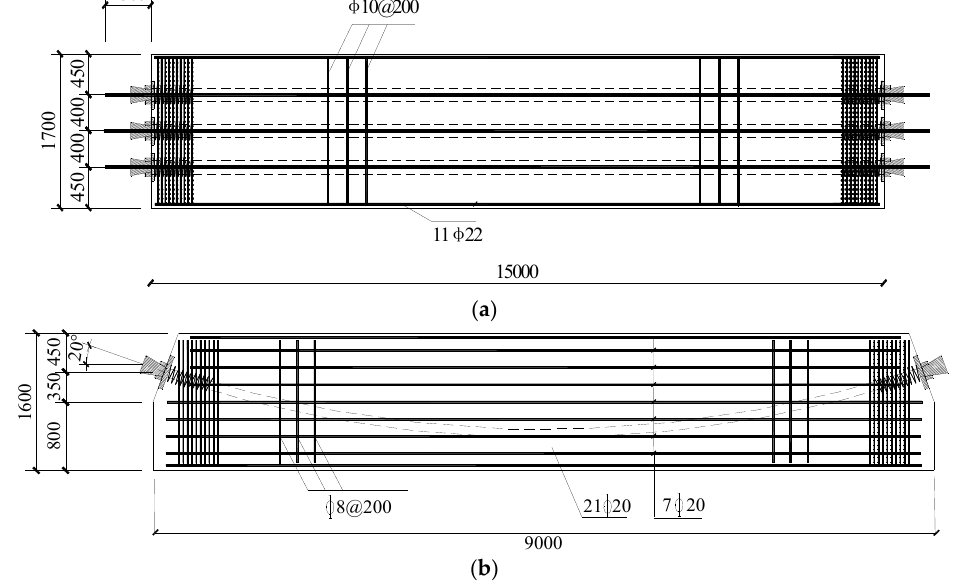
Figure 7. Dimension of specimens: ( a ) specimen for straight tendons; and ( b ) specimen for curve tendons (unit: mm).